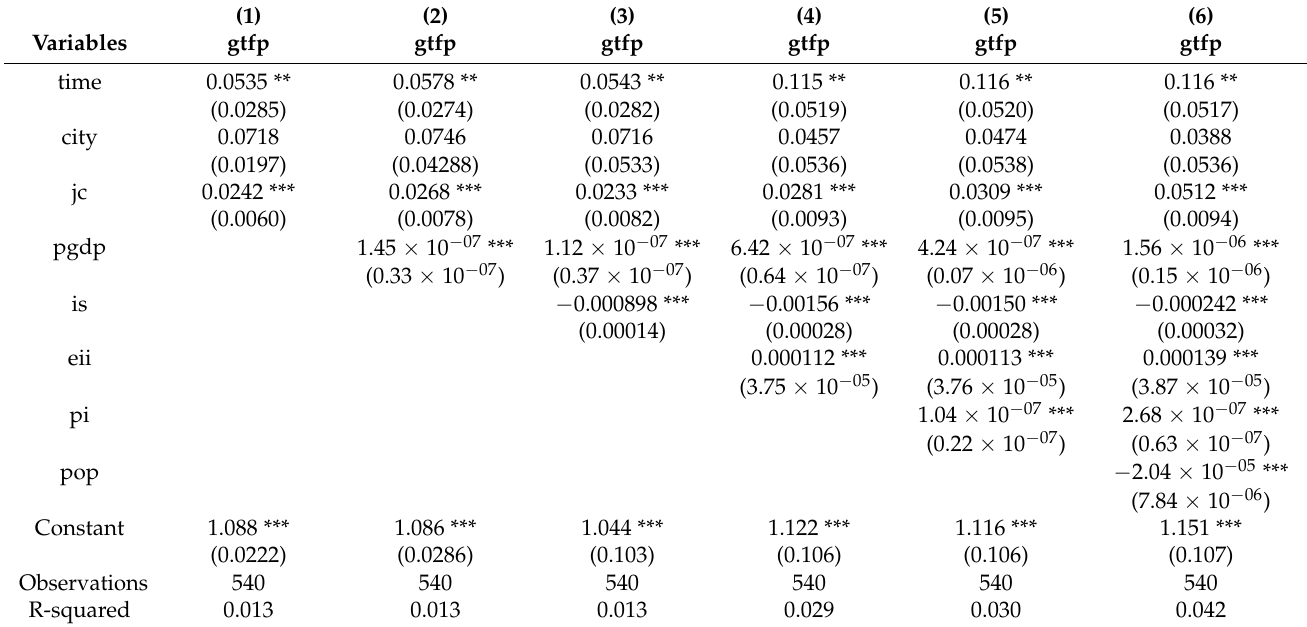
Table 4. Effect of carbon trading policy implementation on green development—difference in differences